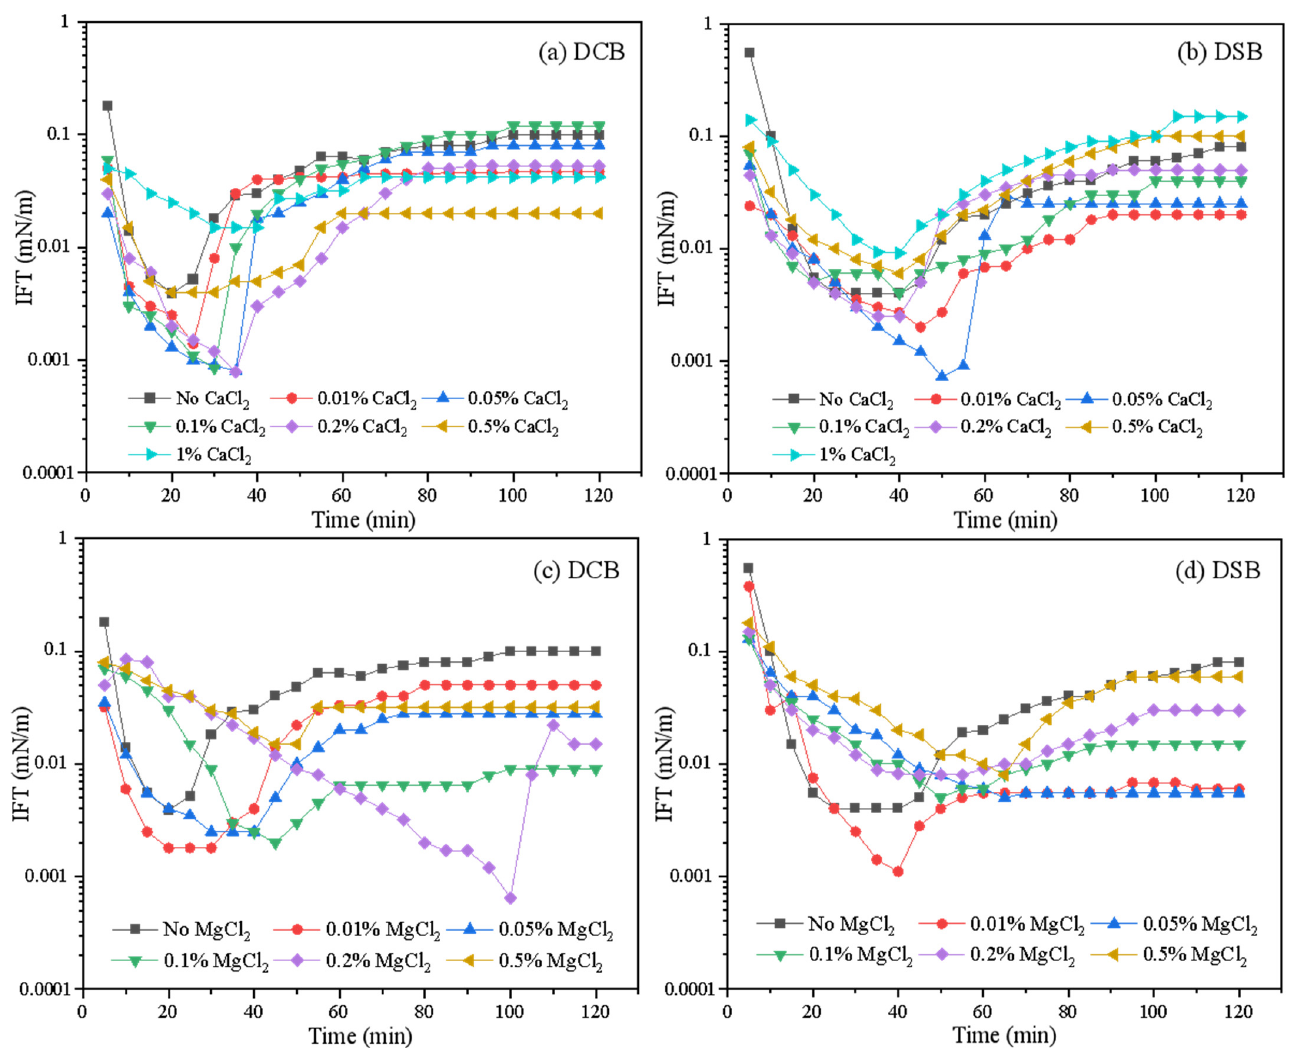
Figure 6. Effects of divalent ion on IFT between the optimum concentrations of surfactants and Xinjiang crude oil at 40 ◦ C for DCB ( a ) and DSB ( b ) of CaCl 2 , DCB ( c ) and DSB ( d ) of MgCl 2